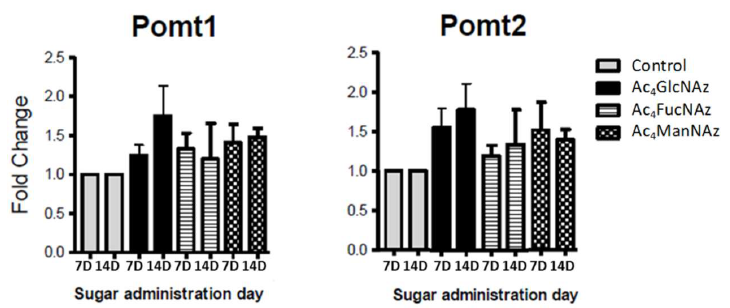
Figure 4. Expression of genes coding protein- O -mannosyltransferases (Pomt1 and Pomt2) after 7 and 14 days in culture (7D and 14D).